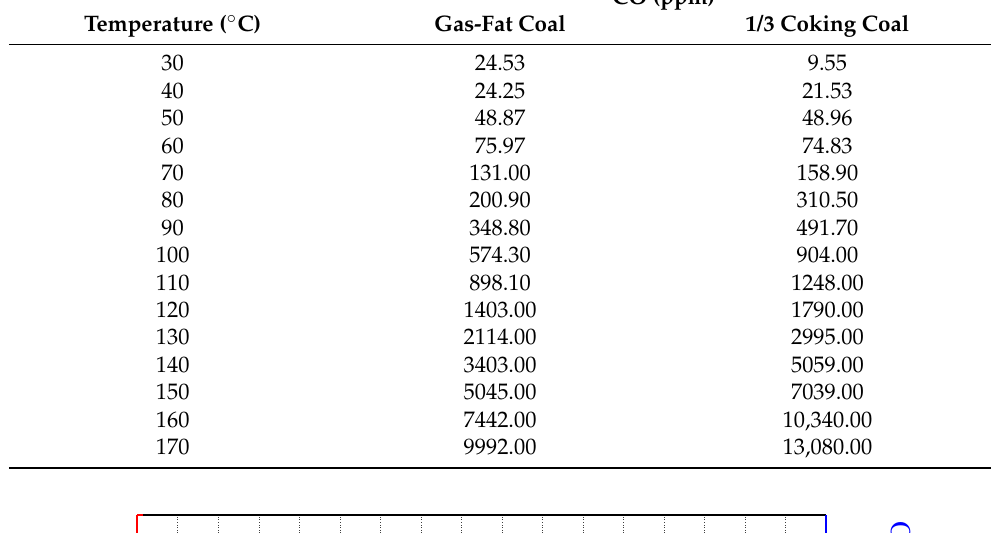
Table 1. CO concentration versus temperature.